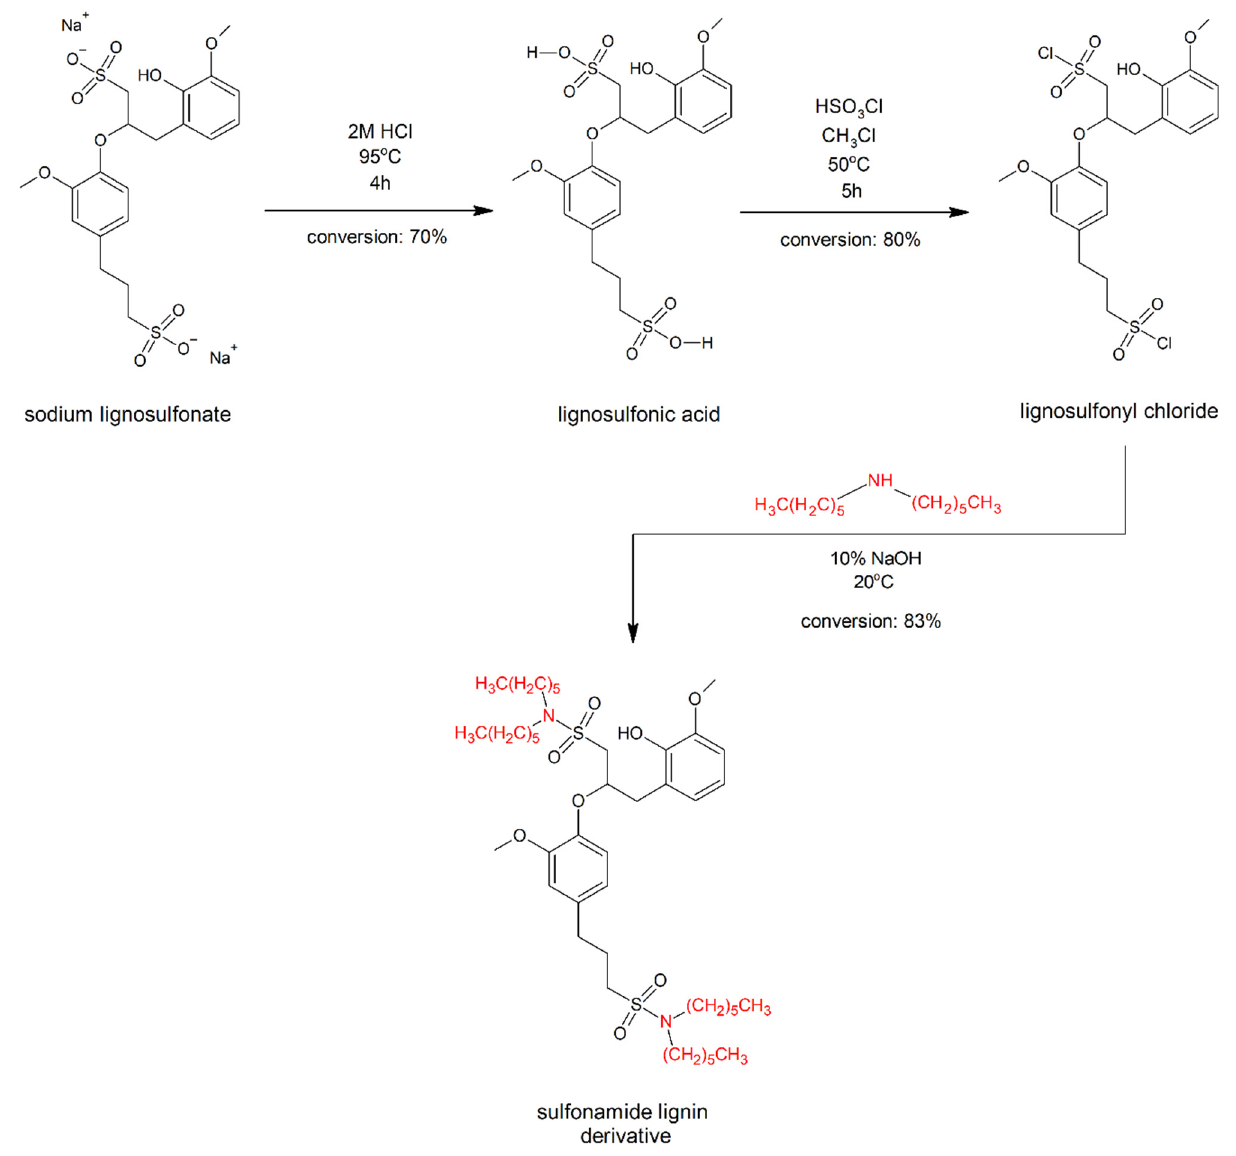
Figure 2. Synthetic route to obtain sulfonamide derivatives of lignin.